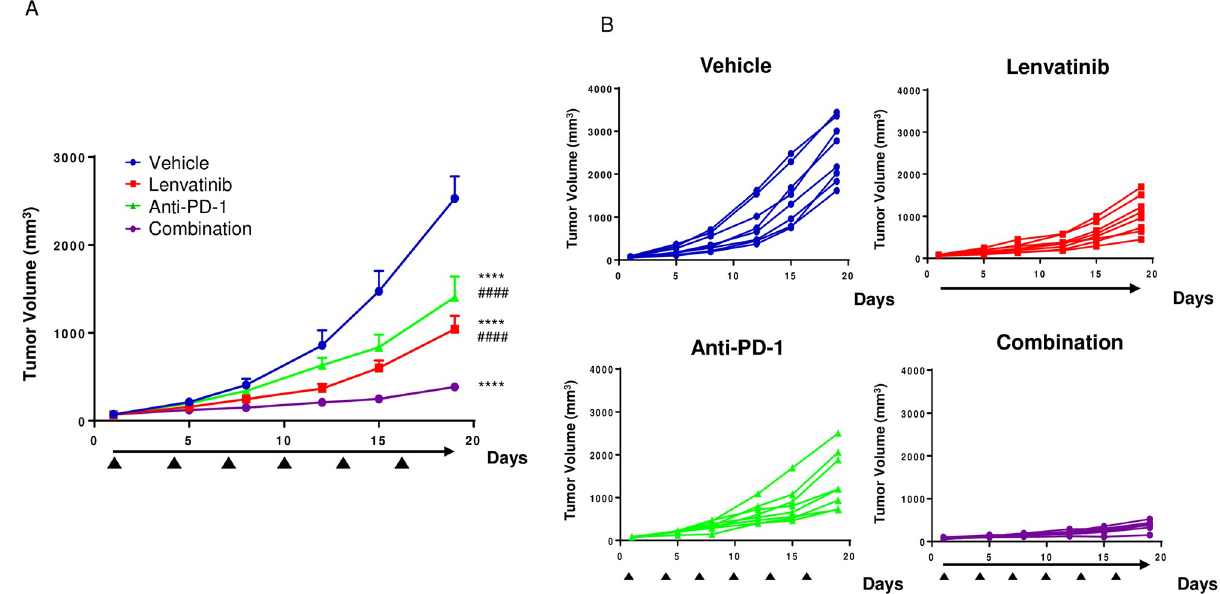
Fig 3. Antitumor effects of lenvatinib treatment alone or in combination with anti-PD-1 in the CT26 model. A. Mice were inoculated with CT26 cells and randomized into groups of 8 with an average tumor volume size (Day 1 mean TV, 32.6 mm 3 ) and were then treated with vehicle (blue circles), 10 mg/kg lenvatinib (red squares) once daily, anti-PD-1 at 200 μ g/mouse (green triangles) once every 3 days, or a combination of lenvatinib plus anti- PD-1 (purple circles). Lenvatinib treatment is indicated by the black arrow; anti-PD-1 treatment is indicated by black triangles. B. Tumor volumes for individual mice are shown for each treatment group. Error bars represent the SEM. ���� P < 0.0001, Dunnett’s test vs. vehicle on Day 19; ## P < 0.01, #### P < 0.0001 vs. combination.